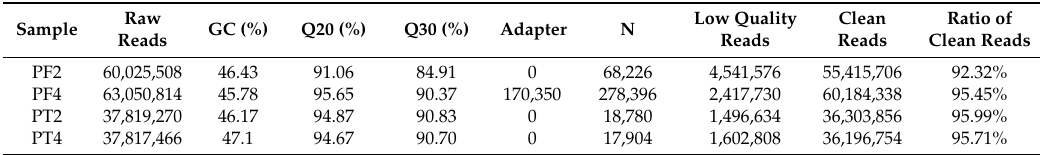
Table 1. Assessment of the transcriptome sequencing